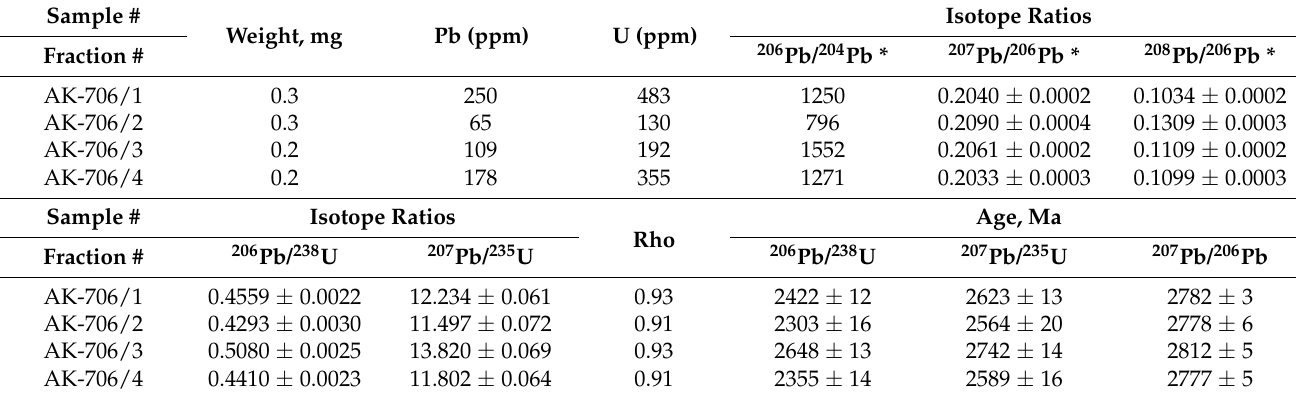
Table 3. Results of U–Pb geochronological studies of zircons from the Oleninskoe deposit.